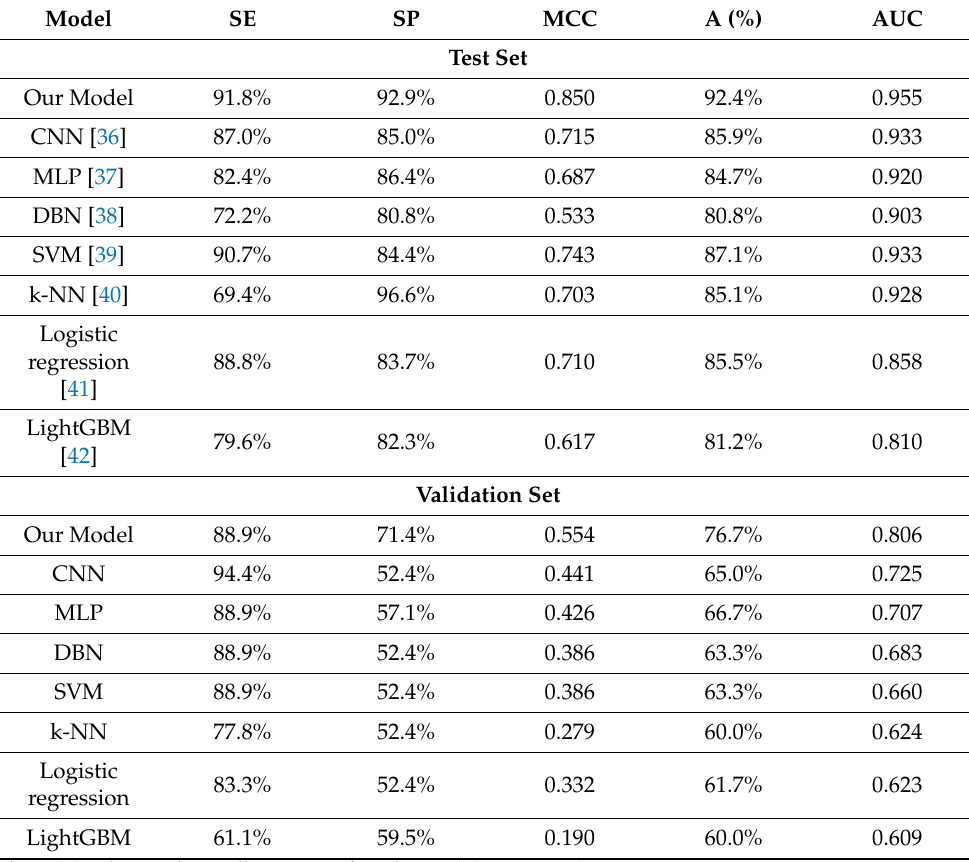
Table 4. Comparison of accuracies of the same training dataset of smoke and fire classification for different